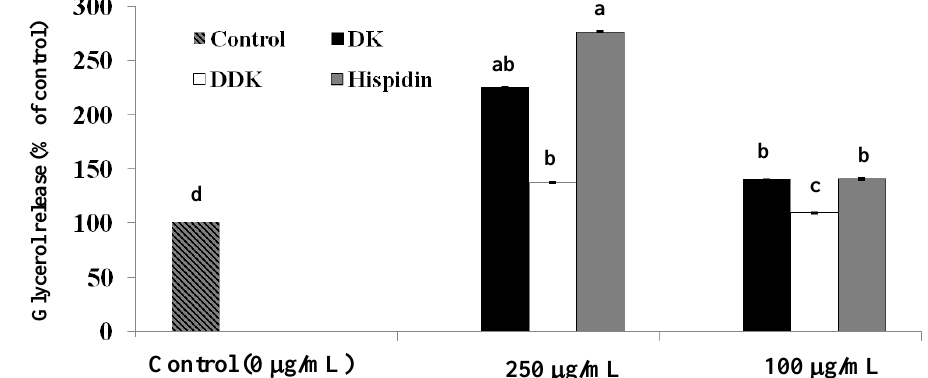
Figure 4. The effect of hispidin, DK and DDK on glycerol release in 3T3-L1 adipocytes. Differentiated 3T3-L1 cells were treated with various concentrations of isolated compounds and incubated for 72 h at 37 °C in a humidified incubator containing 5% CO 2 . Cell supernatants were collected and free glycerol release was assayed. Reported values are the means ± SE ( n = 3). Letters with different superscripts indicate samples that are significantly different ( p < 0.05) compared with the